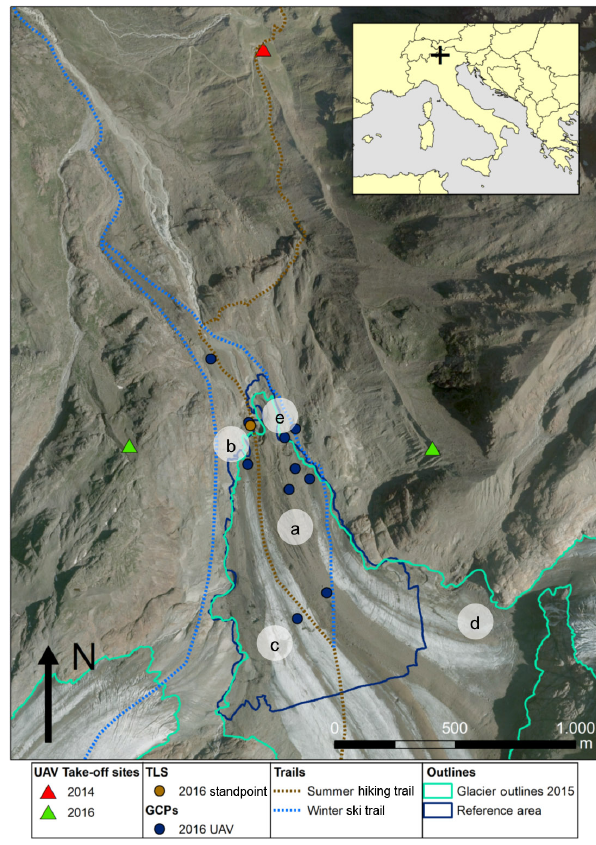
Figure 1. The tongue of Forni Glacier. The map shows the location of take-off and landing sites for the 2014 and 2016 UAV surveys, standpoint of TLS survey, GCPs used in the UAV photogramme- try surveys and trails crossing the glaciers. Letters a–e identify the location of features described in Fig. 2. Base map from 2015 cour- tesy of IIT Regione Lombardia WMS Service. Trails from Kom- pass online cartography at https://www.kompass-1039italia.it/info/